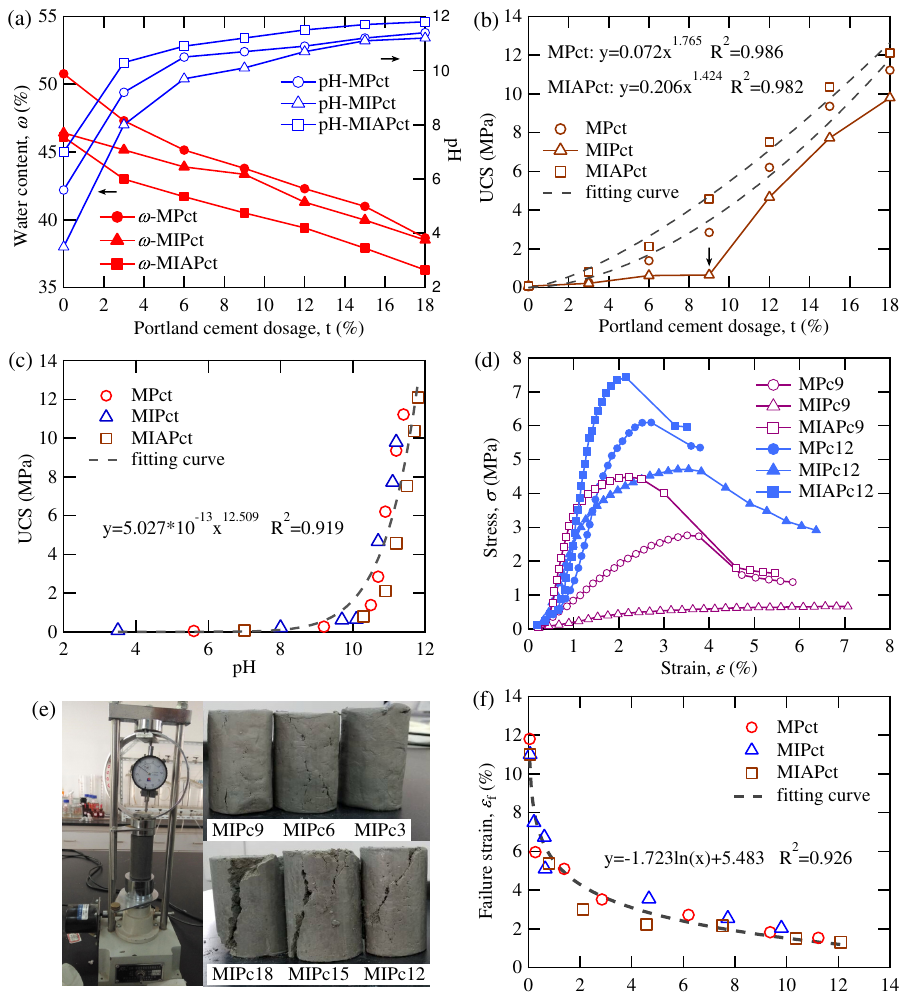
Figure 5. Results of water content tests, pH tests and UCT: ( a ) Water content and pH-value at different Portland cement dosage of different samples; ( b ) UCS at different Portland cement dosage of different samples; ( c ) Relationship between UCS and pH-value for all samples; ( d ) Stress-strain curves from UCT of partial samples; ( e ) DW-1 electrodynamic strain-controlled unconfined pressure gauge and the failure modes of partial samples after UCT; ( f ) Relationship between failure strain and UCS for all